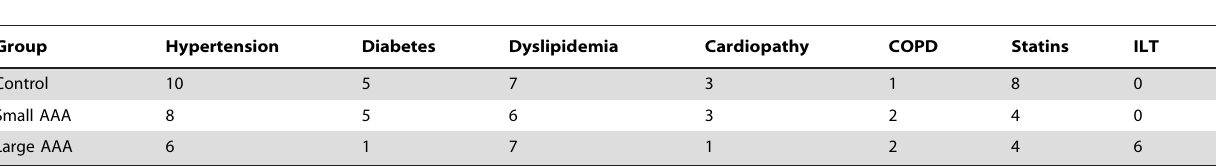
Table 1. Characteristics of study